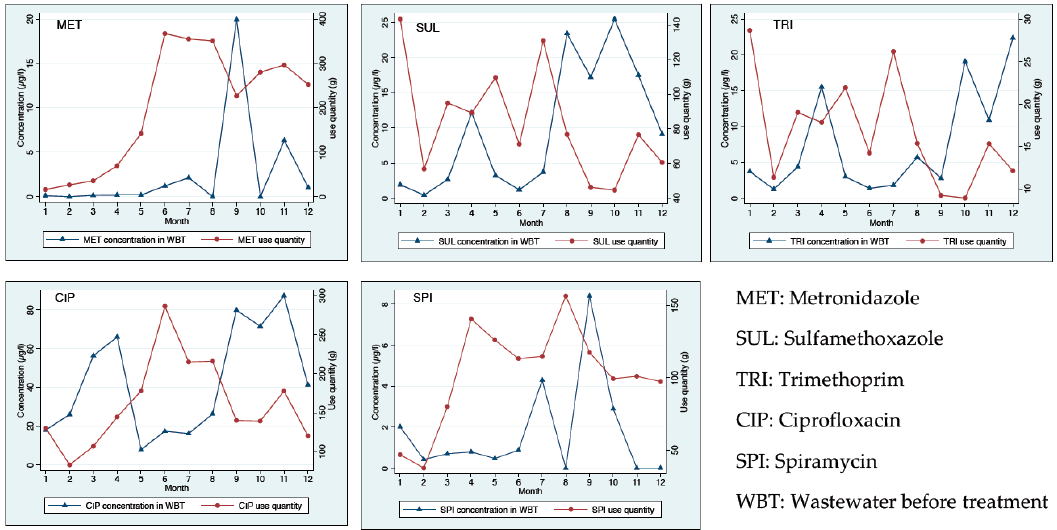
Figure 1. Relationship between quantities of antibiotics used and residues of studied antibiotics in wastewater before treatment of a rural hospital in Vietnam.